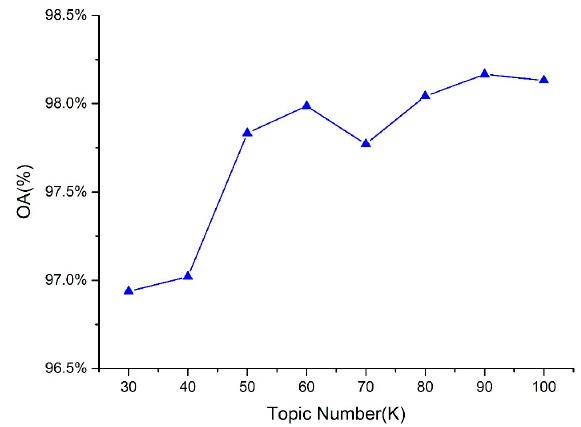
Figure 9. Some of the classification results of the different methods. The four rows correspond to the four classes of aurora image. ( a ) Correctly classified images for all the methods. ( b ) Images classified correctly by AI-MFLDA, but incorrectly classified by the other methods.